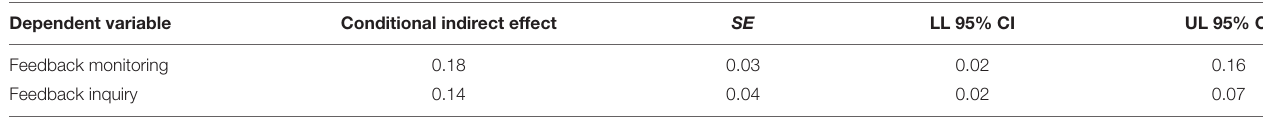
TABLE 4 | Results of bootstrap for the indirect effect of feedback seeking on supervisor feedback environment via supervisor identification. Dependent